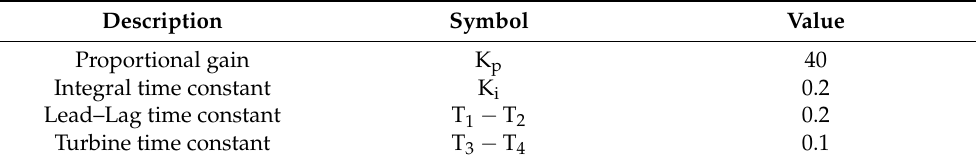
Figure 2. Dynamic model of governor and turbine in a CHP unit. Table 1. Governor-turbine parameters of the MG’s